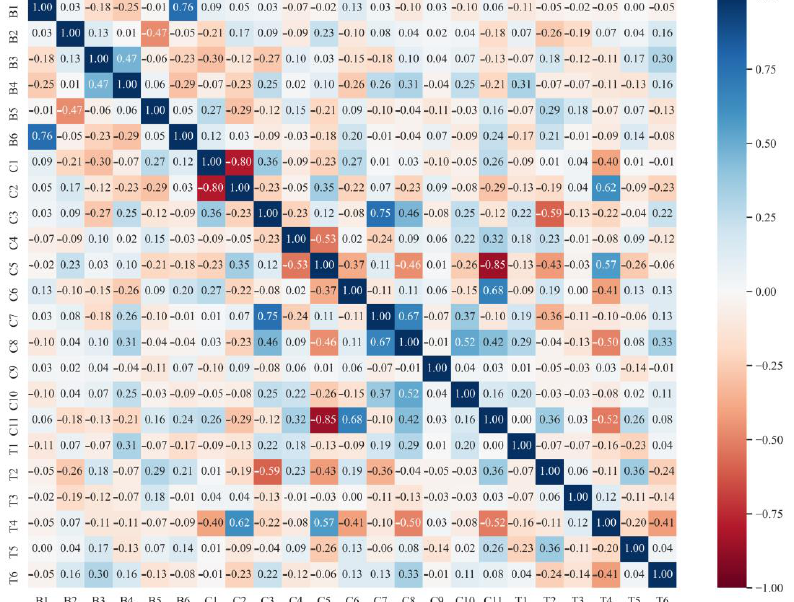
Figure 7. Correlation coefficient ( r ) values between proposed structural parameters. The darker the blue color, the higher positive the correlation between structural parameters. The darker the red color, the higher negative the correlation between structural parameters.